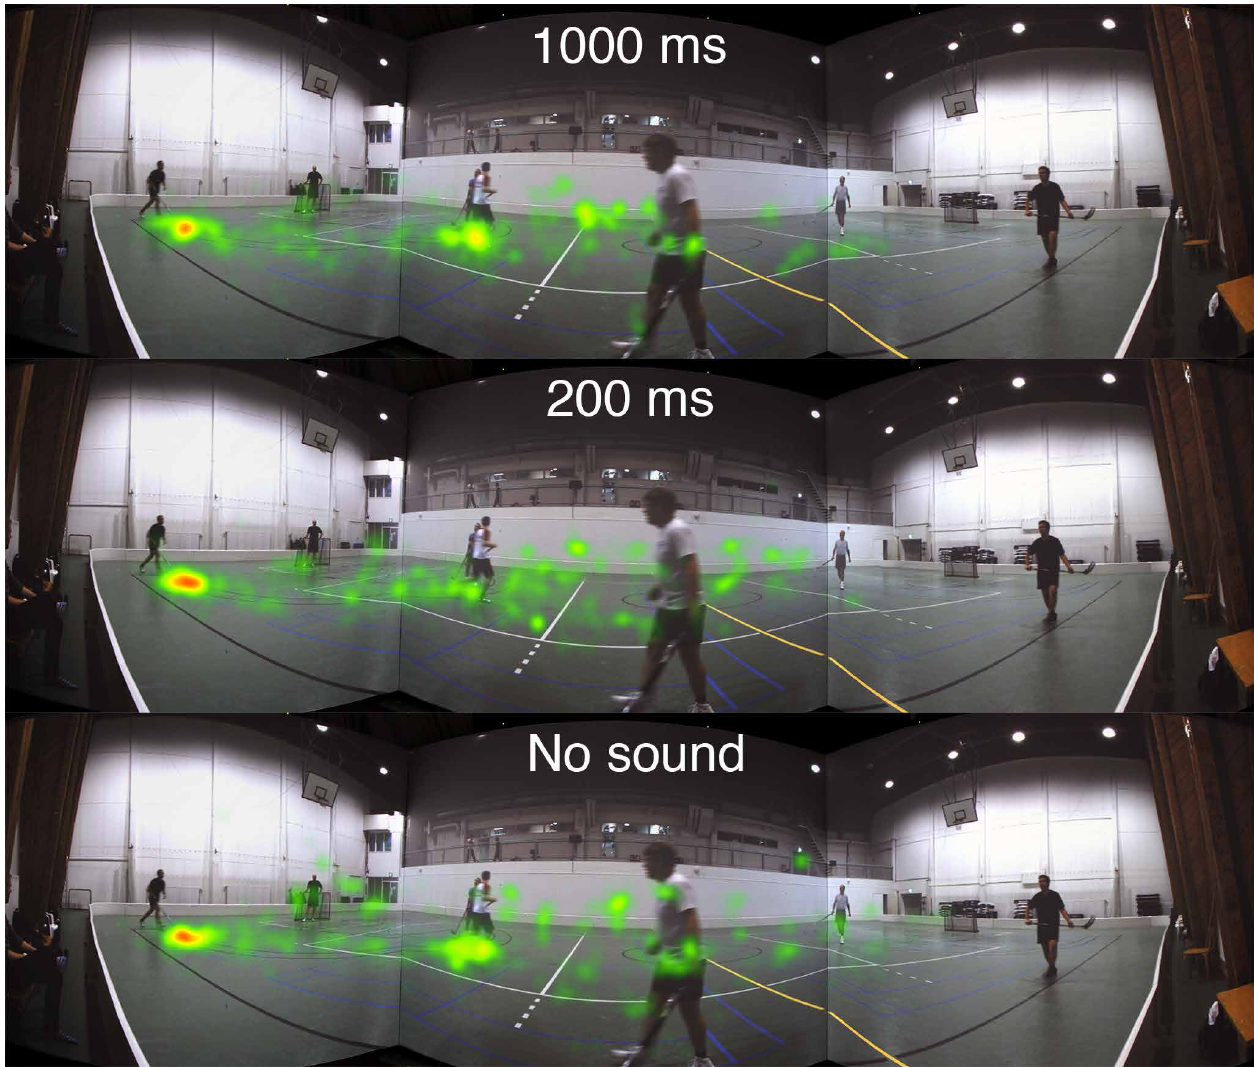
Figure 9 . Uninformative sound (Uninformative 1): Heatmap for the accumulated fixation count of the first 1000 ms after the scene cut to a floorball scene containing uninformative sound. The fixations are counted across all 11 participants. Three different audio conditions are displayed: 1000 ms lead, 200 ms lead, and No sound , from top to bottom. The color codes are: red > 60 fixations, yellow 30-60 fixations, and green 1-30